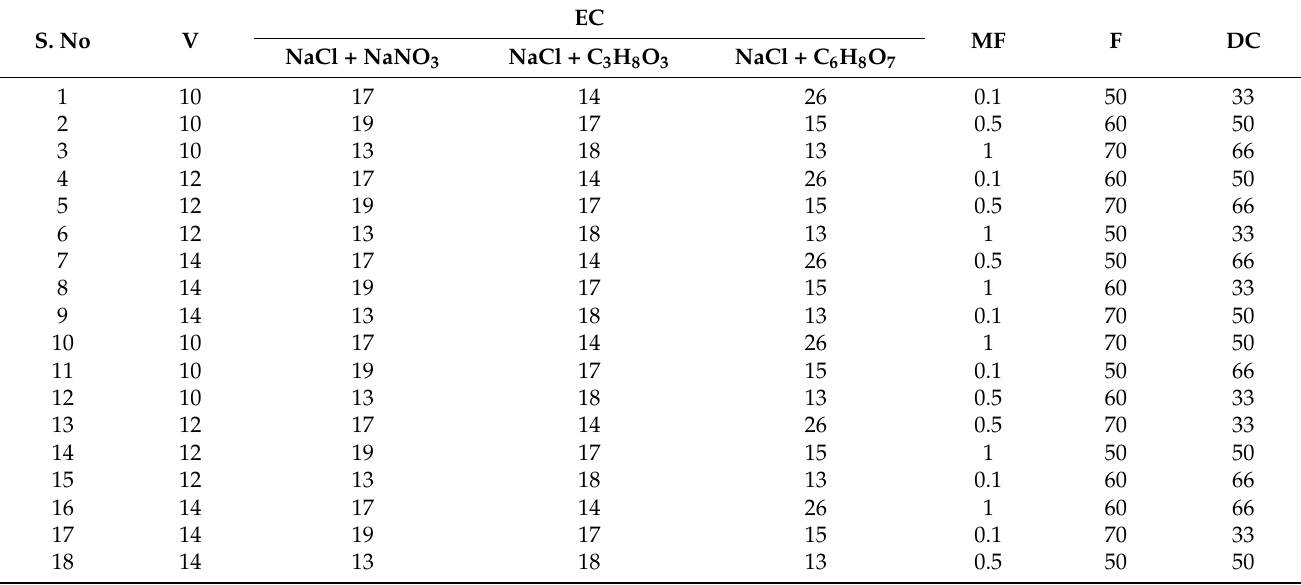
Table 2. Experimental methodology of the present